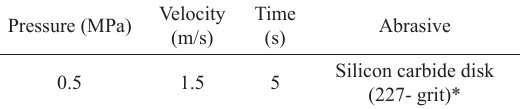
Table 2: Parameters used in the pin-on-disk wear tests.